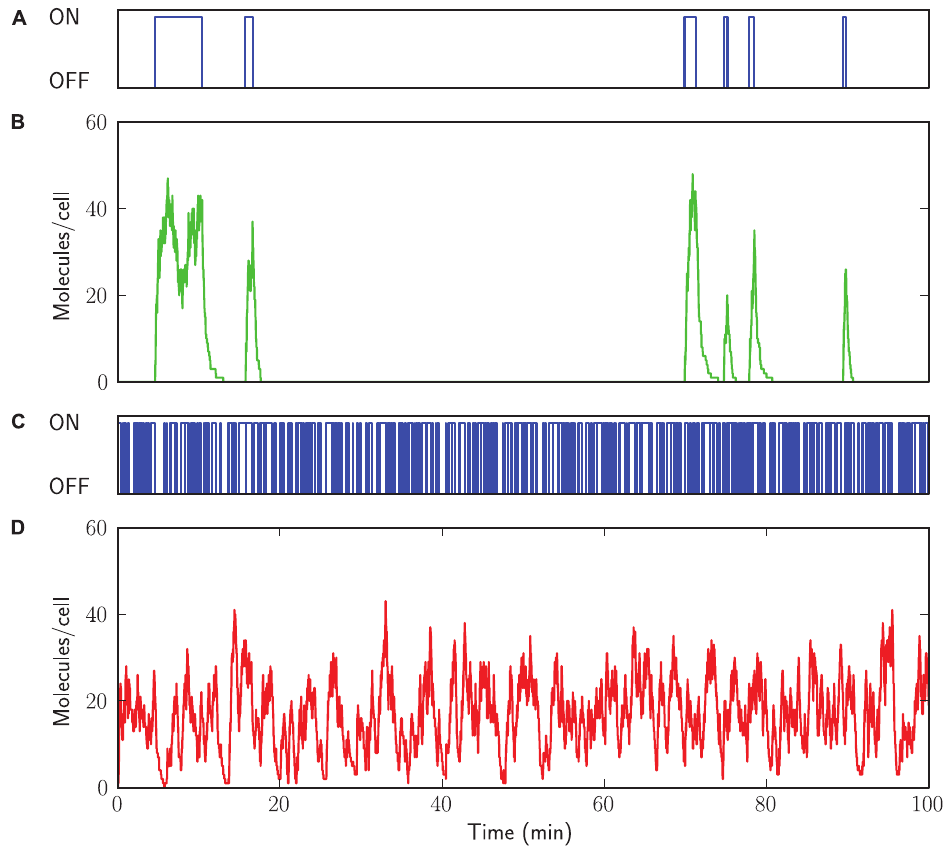
Figure 4. Time series of bursty and non-bursty transcription. StochPy plots of simulating stochastic gene expression. (A) long lifetimes of both the ON and OFF state. (B) bursty transcription. (C) short lifetimes of both the ON and OFF state. (D) non-bursty transcription.